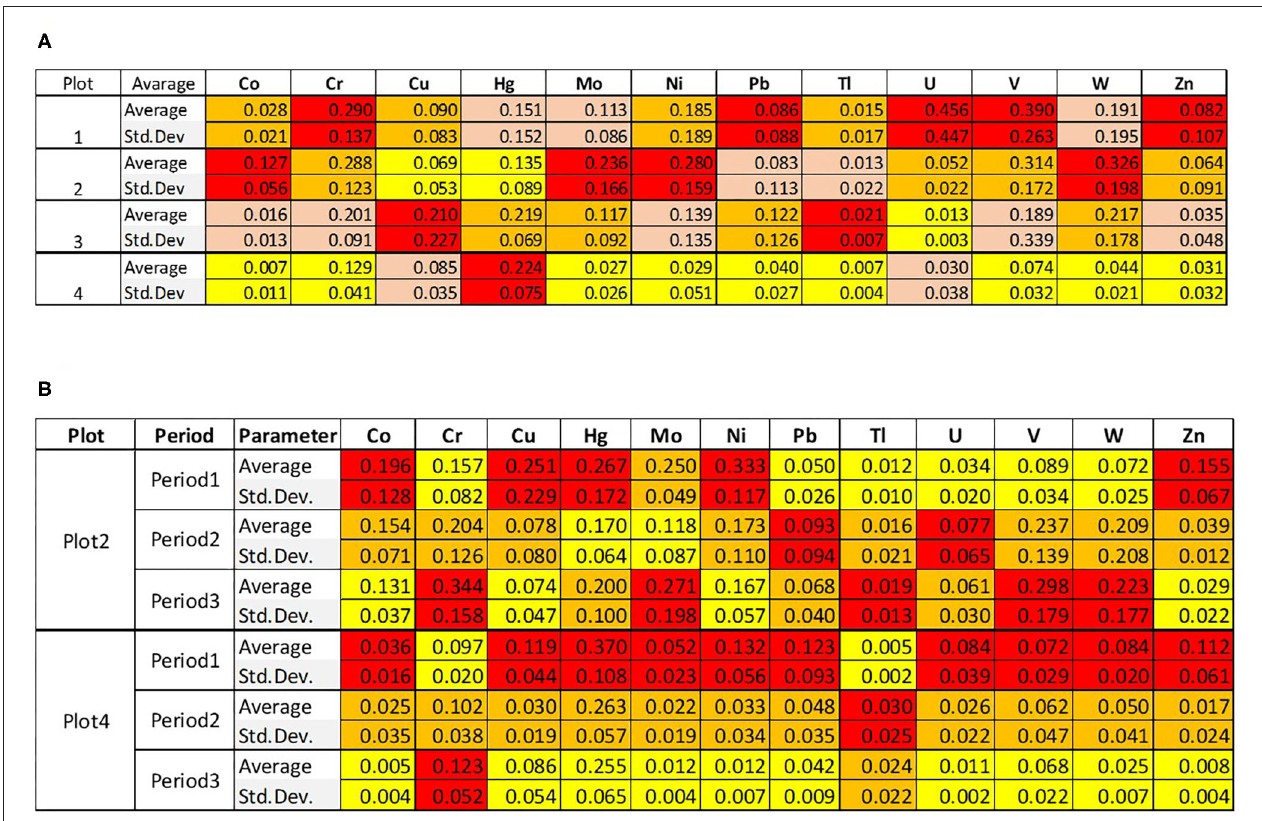
FIGURE 3 | The average value of index level of trace elements (A) in the plots and (B) in the each plot for each period analyzed. The colors from yellow to red refer from the lower to higher average